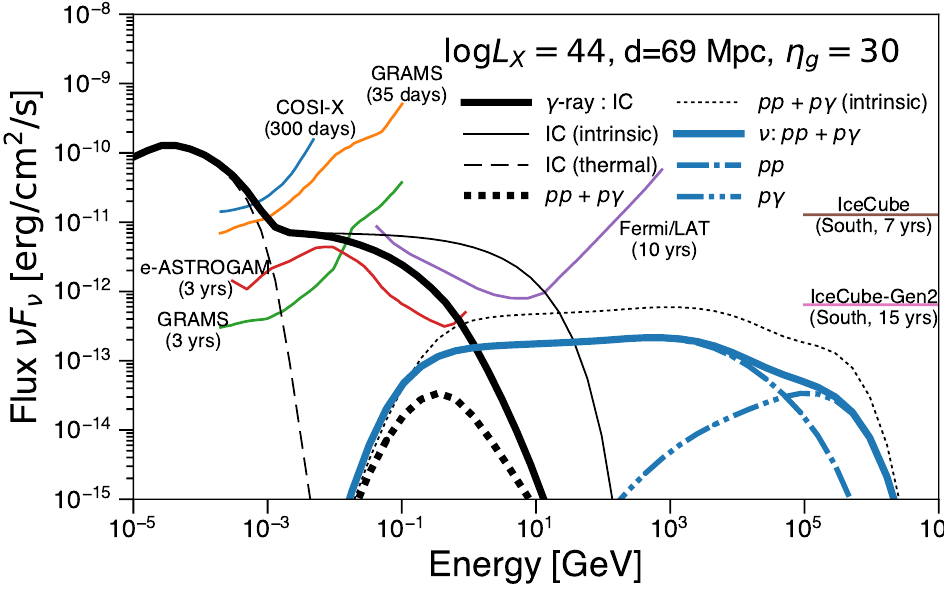
Figure 10. Gamma-ray and neutrino spectra per flavor from AGN coronae with p inj = 2.0 and η g = 30. We set 2–10 keV luminosity of 10 44 erg s − 1 at a distance of 69 Mpc (IC 4329A). The thick black solid and thick dot curves show gamma rays from IC interaction and pp + p γ interaction including the attenuation effect. Each thin curve shows the spectrum before the attenuation. Taken from Inoue et al.